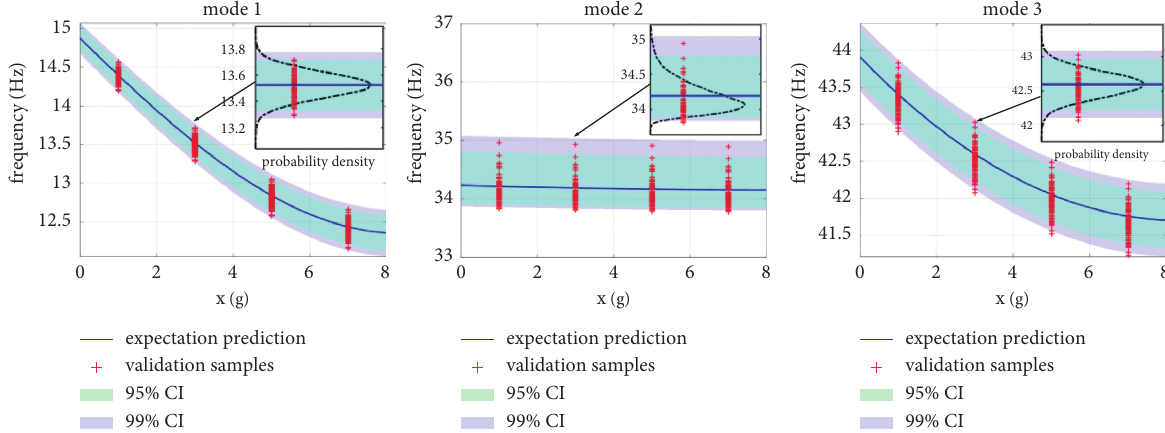
Figure 16: Prediction stripe with probability distribution for natural frequencies versus excitation plotted with blue solid lines. The 95% and 99% CIs are plotted with green and purple stripes. Moreover, the PDFs of frequencies at any specified excitation could be obtained as plotted with black dashed lines. It is demonstrated that